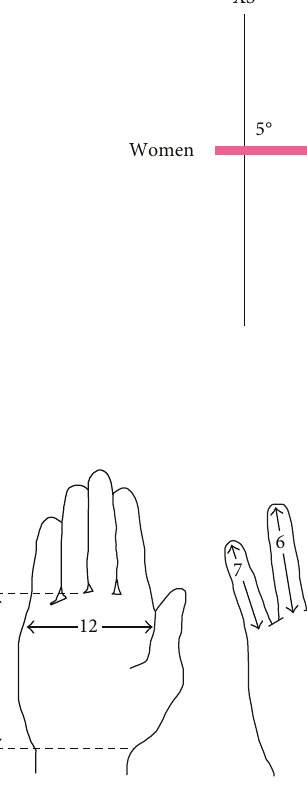
Figure 6: Reference measurements (adapted from pheasant [22]).